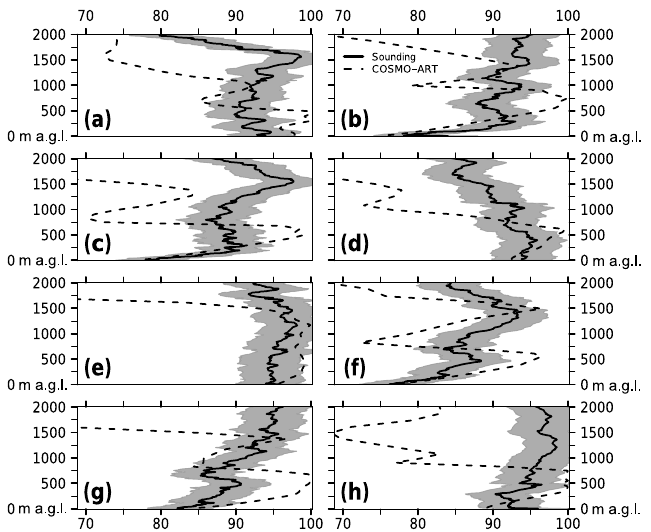
Figure B3. Same as Fig. B2 but for (a) 6 July 04:00UTC, (b) 6 July 10:00UTC, (c) 6 July 16:00UTC, (d) 6 July 23:00UTC, (e) 7 July 04:00UTC, (f) 7 July 10:00UTC, (g) 7 July 16:00UTC and (h) 7 July